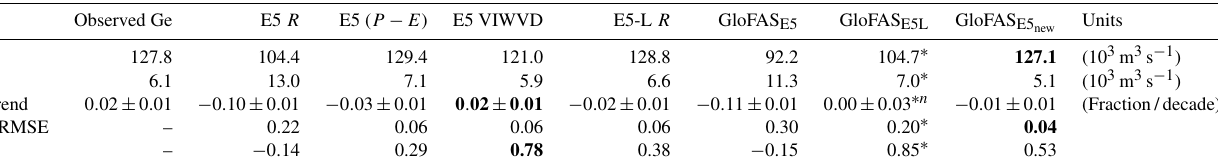
Table 6. Mean values and standard deviations of pan-Arctic river discharge in m 3 s − 1 × 10 − 3 as well as decadal relative trends, calculated over the period 1981–2019 (1999–2018 for GLOFAS E5L , indicated by ∗ ). Insignificant trends are indicated by the superscript n . Bold values identify the best estimates with respect to long-term means, trends, correlation coefficients, and NRMSE values.